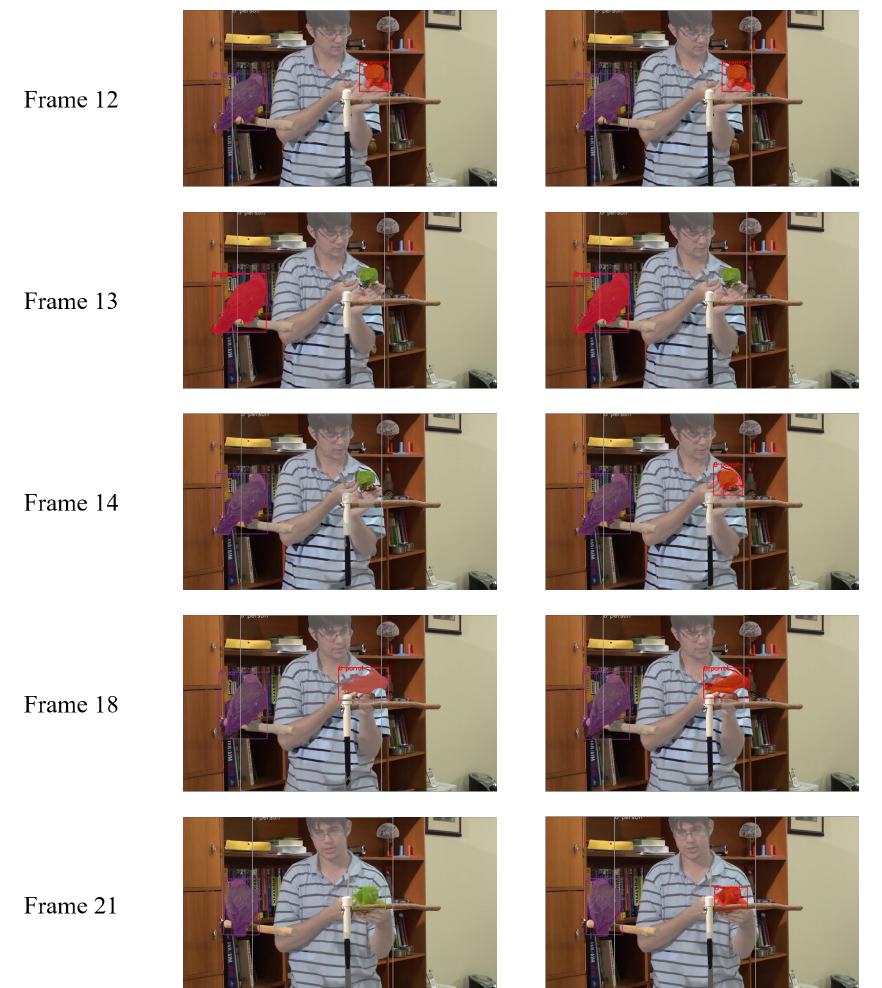
Figure 3. An example of the query update mechanism’s effect. At each frame, the left image is the result as we update ISQs after each frame. The right image is the result when we apply our update mechanism. The same color represents predictions from the same query slot. We illustrate detections with scores greater than 0.3.